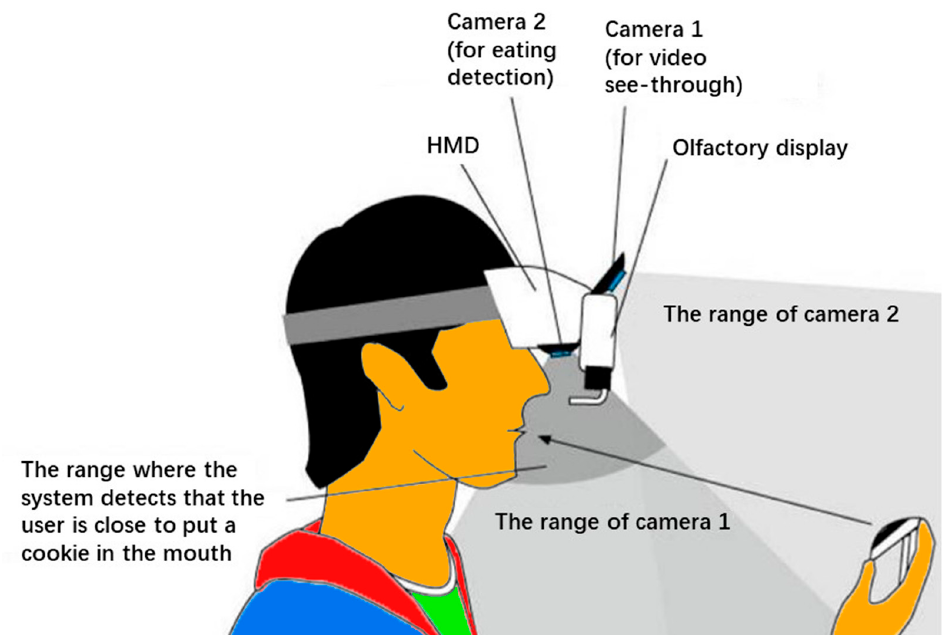
Figure 4. Layout of two cameras, a head ‐ mounted display and an olfactory display. Adapted with permission from Ref. [28]. 2016, Association for Computing